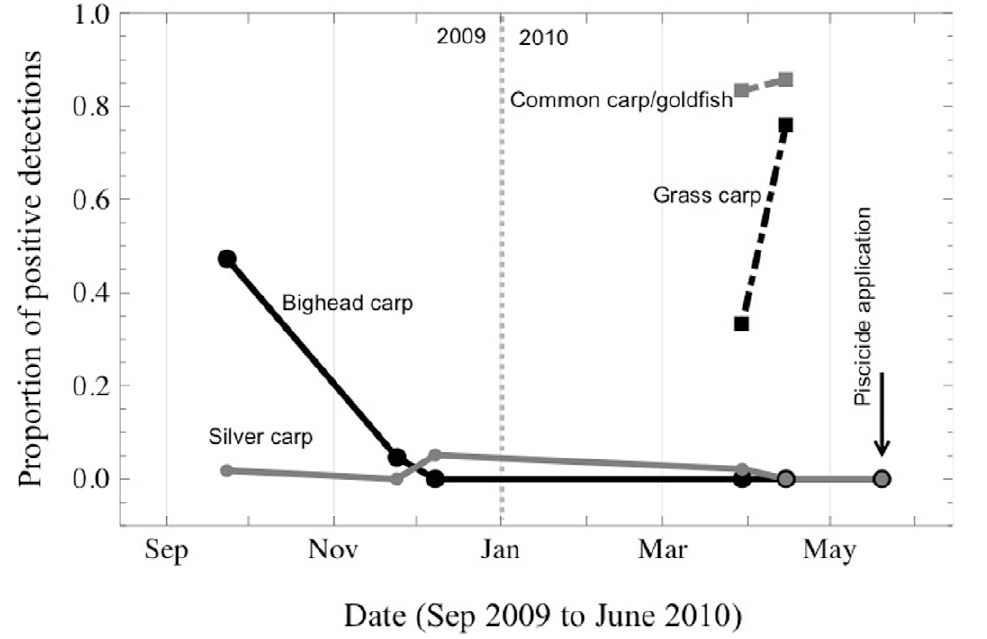
Figure 2. Detection trends of bighead, silver, grass, and goldfish/common carp in the Little Calumet River, in the zone treated with piscicide. Prior to the piscicide treatment, all species except black carp were detected in the treatment reach.